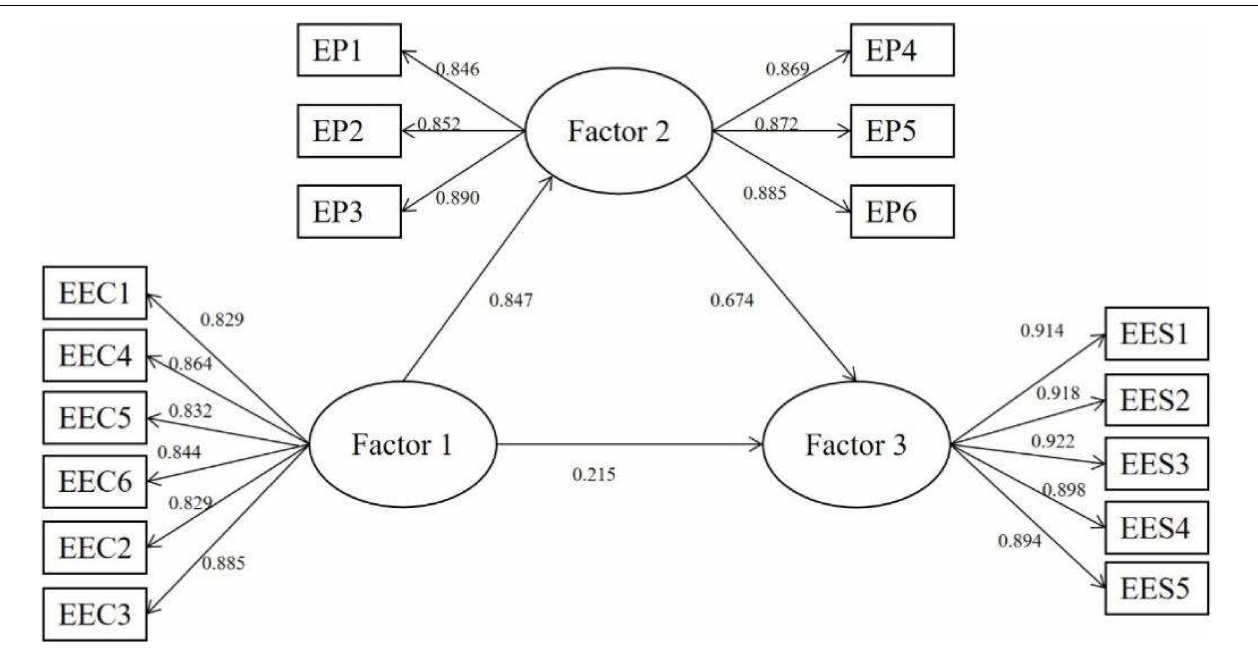
FIGURE 2 | Factor 1, entrepreneurship education curriculum; Factor 2, entrepreneurship practice; Factor 3, entrepreneurship education